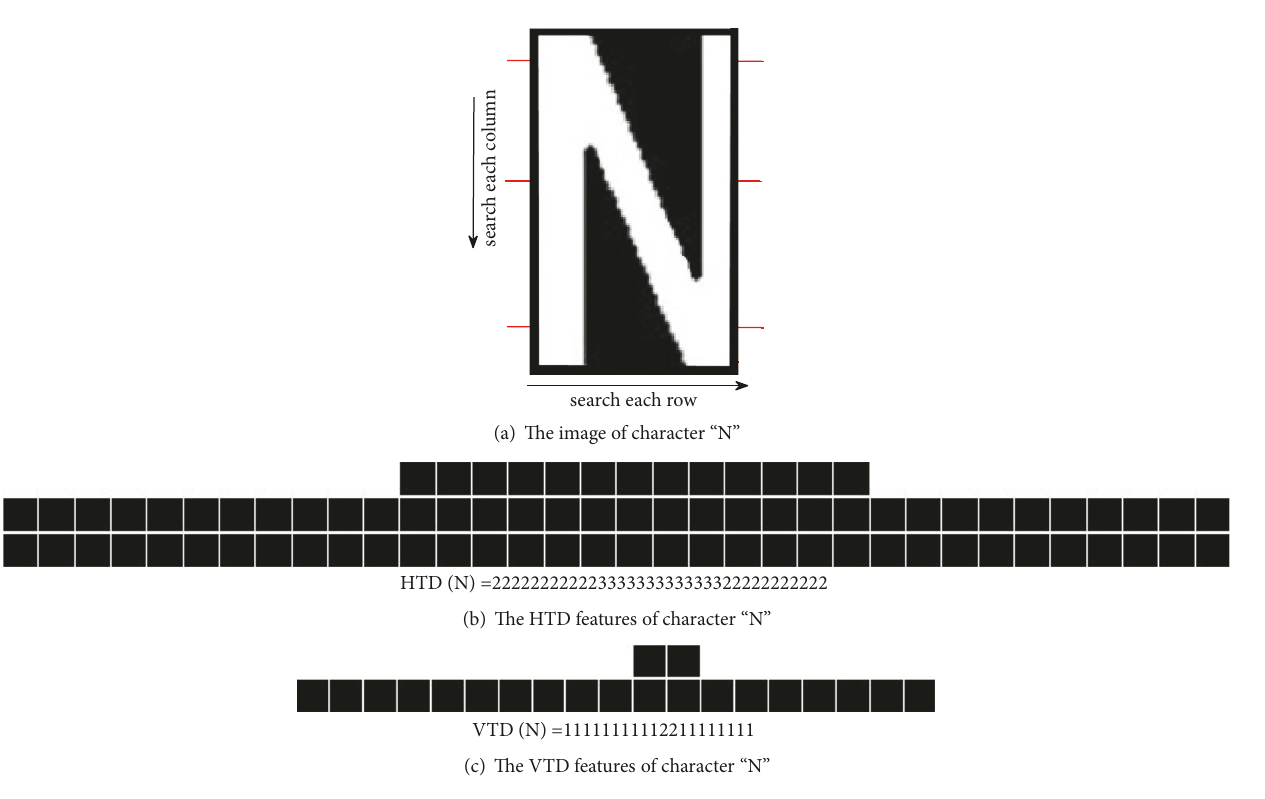
Figure 10: The VTD and HTD features of character “N”.